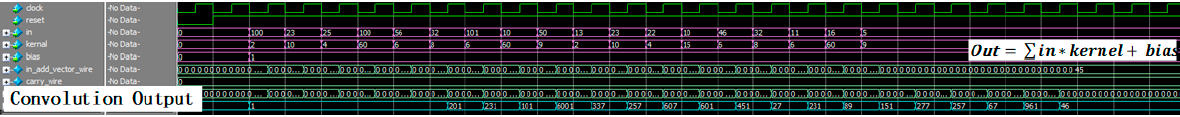
Figure 16. The simulation result of the convolution operation.